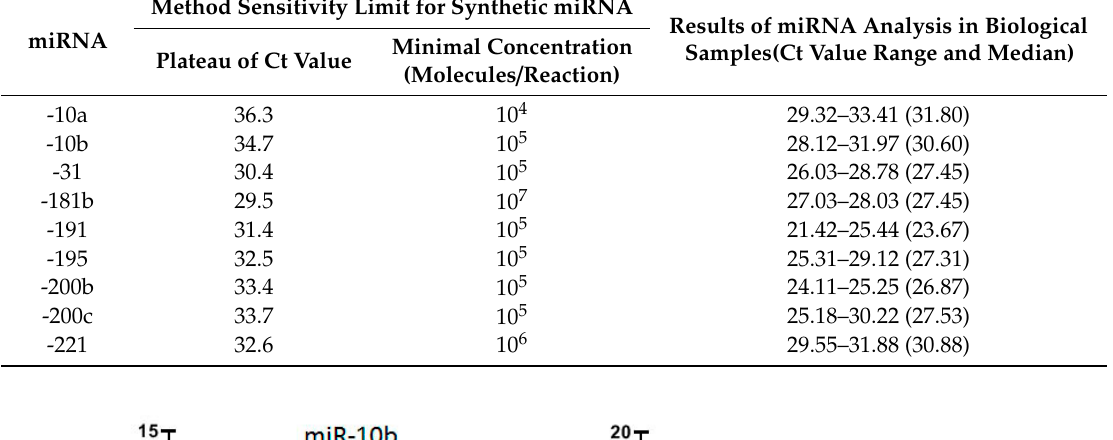
Table 2. Analytic properties of the two-tailed RT-qPCR system for miRNA detection. miRNA